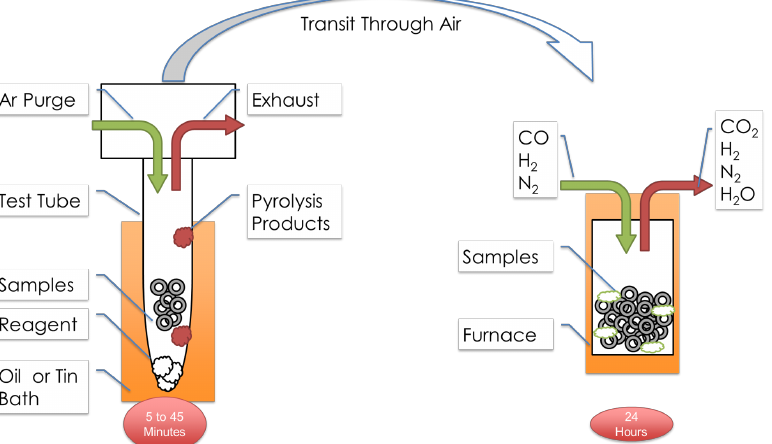
Figure 2. Overview of “Hybrid Processing” for ex situ surface activation via gas from solid-reagent pyrolysis followed by gas-phase low-temperature